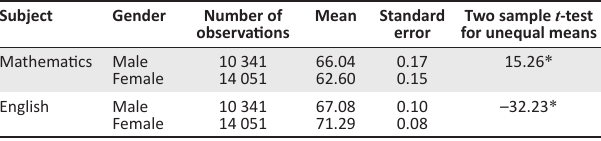
TABLE 9: Two sample test results comparing the Mathematics and English results of men with women (assuming unequal variances in the grouped populations).